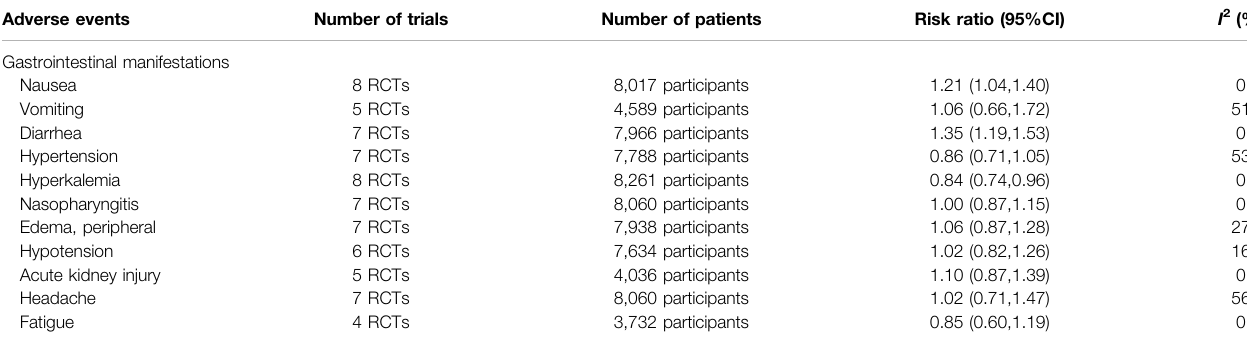
TABLE 3 | Analysis of common adverse